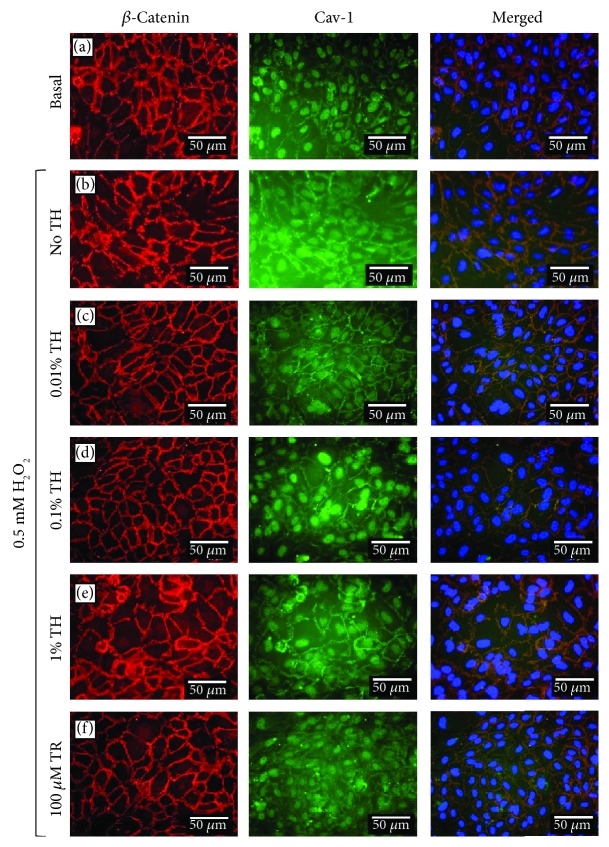
Localization of β-catenin and caveolin-1 in HUVECs pretreated with TH and induced with H2O2. Cellular localization of β-catenin (red) and Cav-1 (green) is shown merged with nucleus (blue) stained with DAPI. Merged images were generated with Olympus BX-51 Cell-F imaging software, whereby a third pseudocolour channel (orange) was used to show colocalization of red and green pixels. Representative images were taken from one of three independent experiments. Basal = untreated; TH = Tualang honey; TR = Trolox.